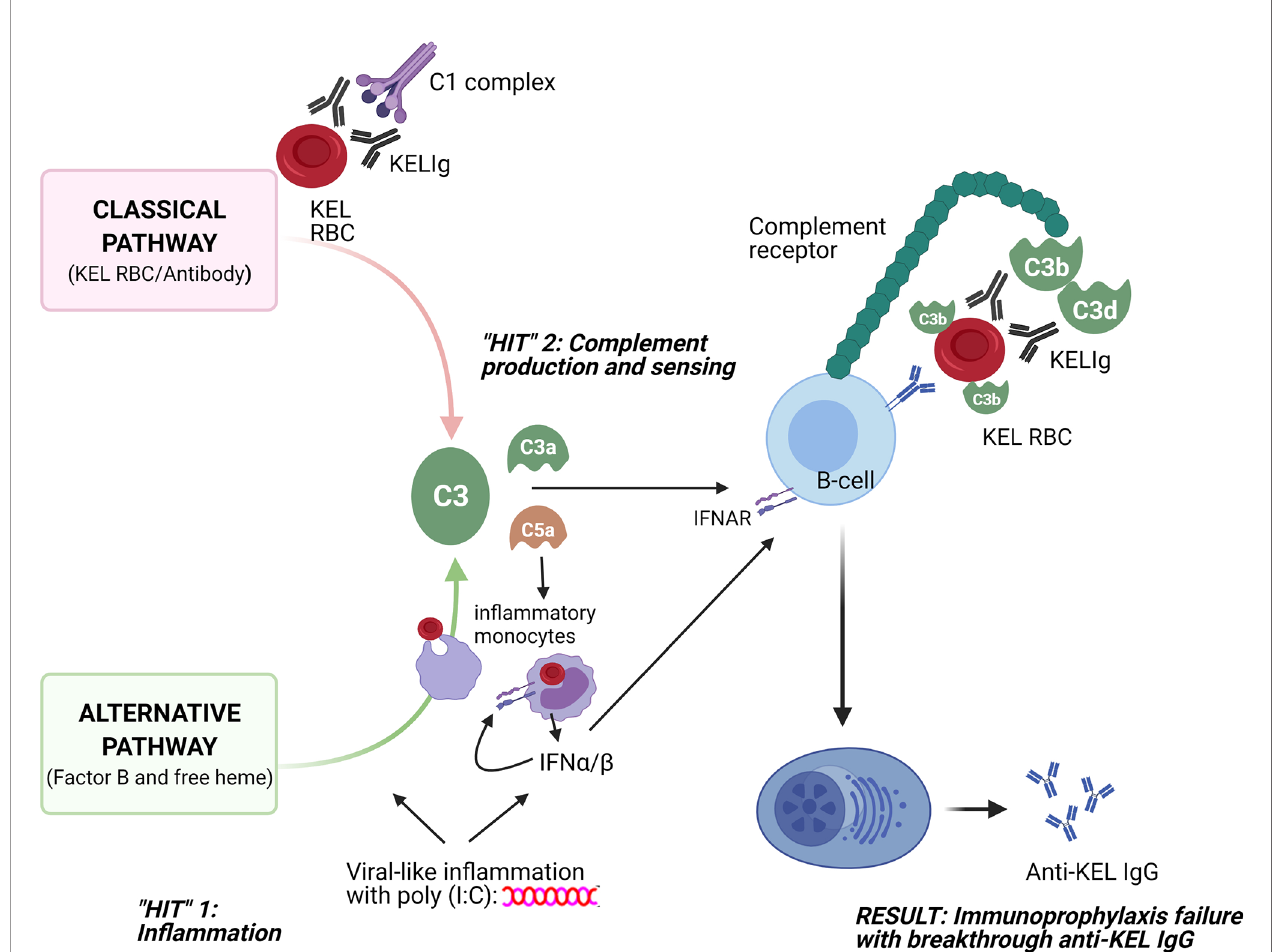
FIGURE 7 | Schematic of 2 “ hits ” resulting in immunoprophylaxis failure in the setting of viral-like in fl ammation. The fi rst “ hit ” involves recipient in fl ammation with poly (I:C), with resultant type 1 ( a / b ) interferon production among other things; the second “ hit ” involves complement generation through the classical pathway due to antibody/antigen interactions and through the alternative pathway due to poly (I:C) and potentially due to free heme generation. Consumption of opsonized RBCs by in fl ammatory monocytes likely also plays a key role, with type 1 IFN and C3a and C5a potentially increasing this consumption and with type 1 IFN generation likely having an impact on downstream B-cells. The sum of these two “ hits ” is that opsonized KEL RBCs with fi xed complement bind to CR1/2 on B-cells, lowering the activation threshold for anti-KEL formation and resulting in in fl ammation-induced immunoprophylaxis